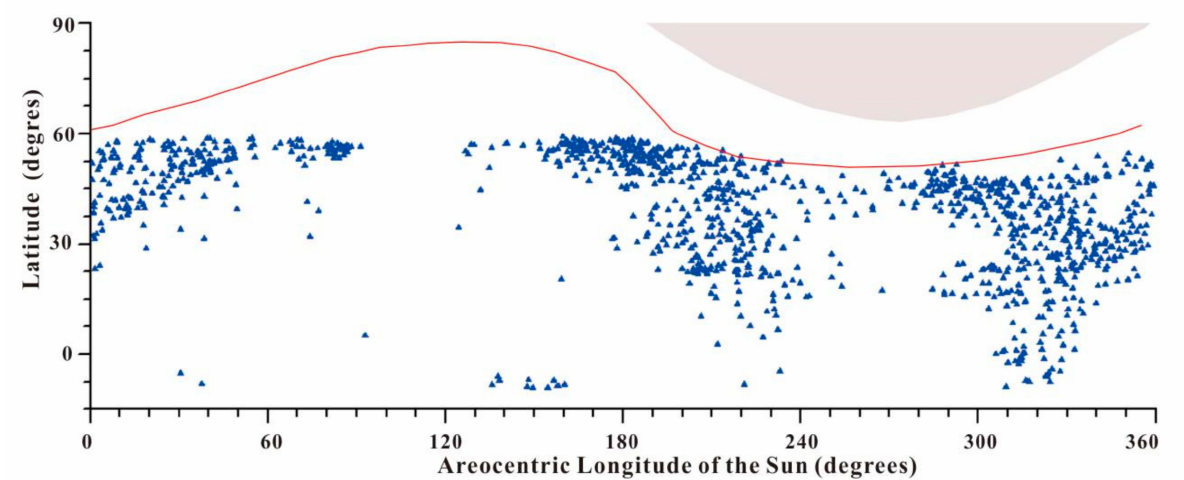
Figure 5. Dust storm latitude distribution, observed within Chryse’s 1600 km-radius ring for every 1 ◦ solar longitude. The red curve indicates the mean latitude of the north polar cap edge, while the gray area at the top shows the terminator. The blue triangles are the centers of dust storm